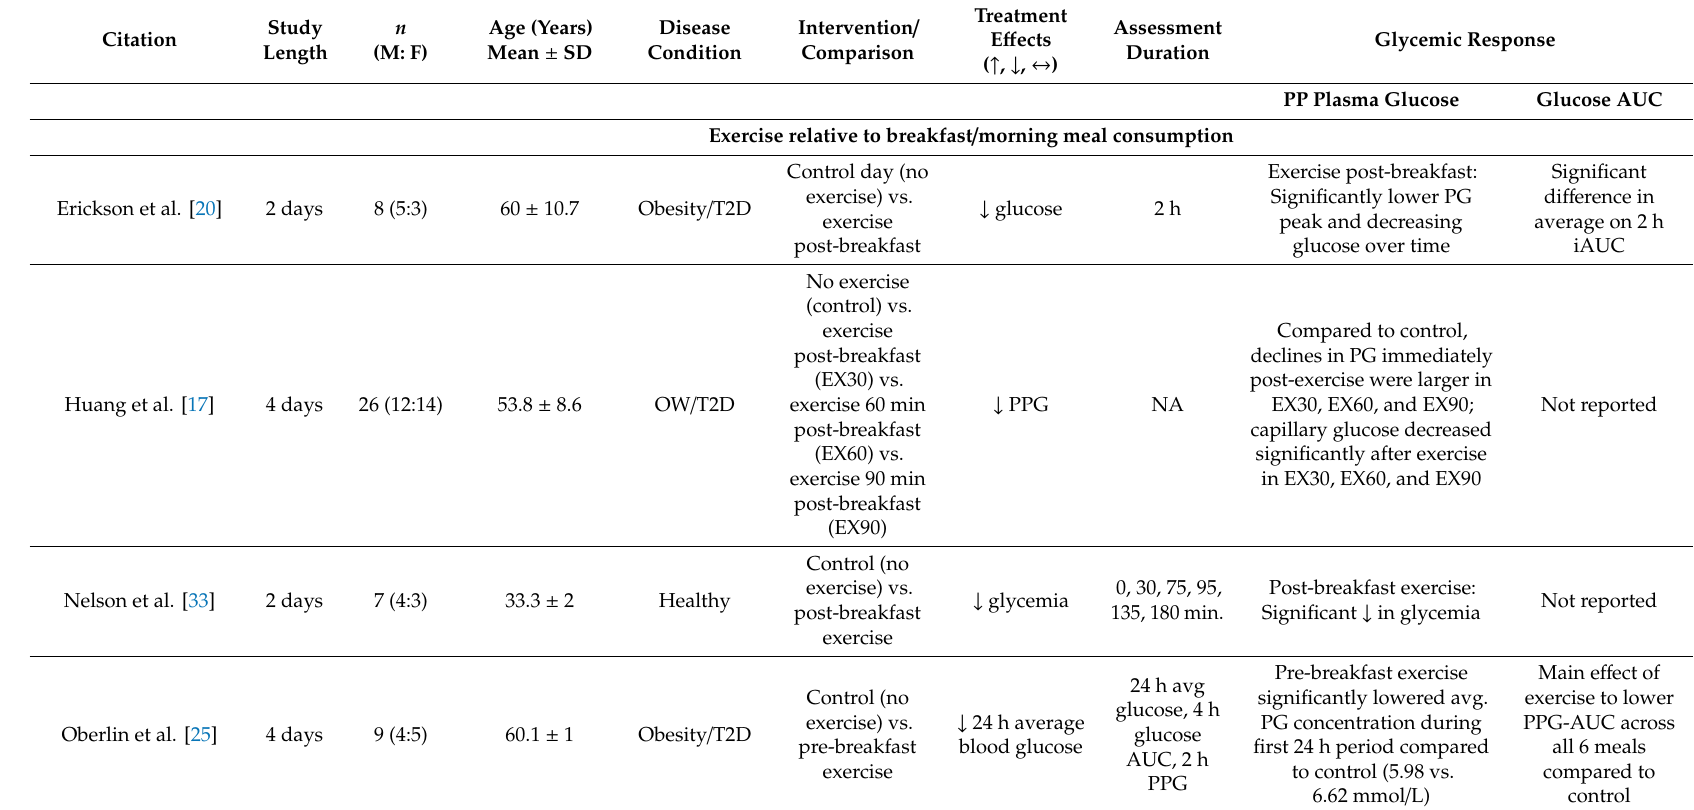
Table 1. Summary of studies included in the systematic